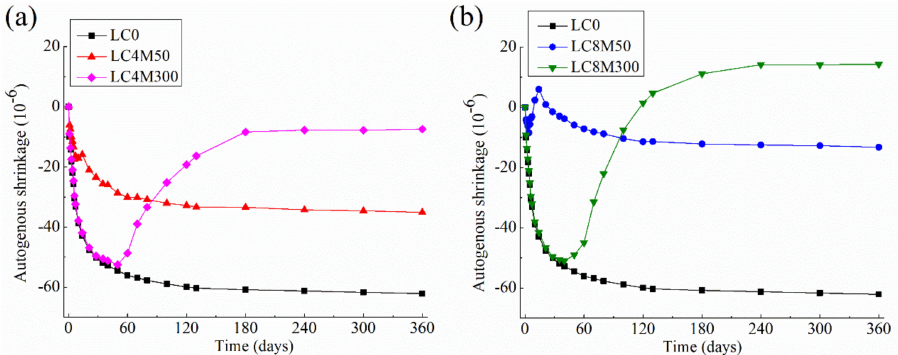
Figure 3. Autogenous shrinkage of LHP concrete containing two kinds of MgO at a dosage of ( a ) 4% and ( b )